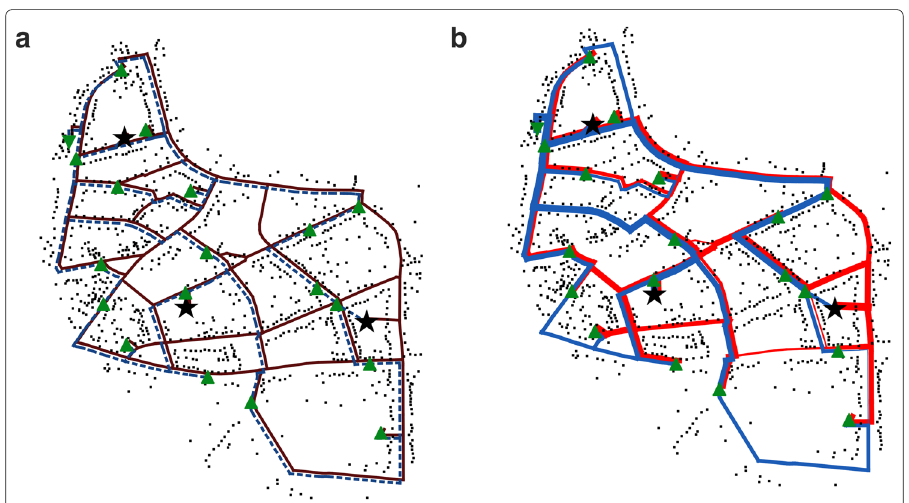
Fig. 3 (a) Overview of test case with 900 buildings (black dots) in 18 grid groups with central conversion nodes (stars), connection nodes (green upwards triangles), and exchange nodes (green downwards triangles). Possible electric (blue) and heat (red) grid connections on the upper grid level. (b) Expansion result of electric and heat grid on upper grid